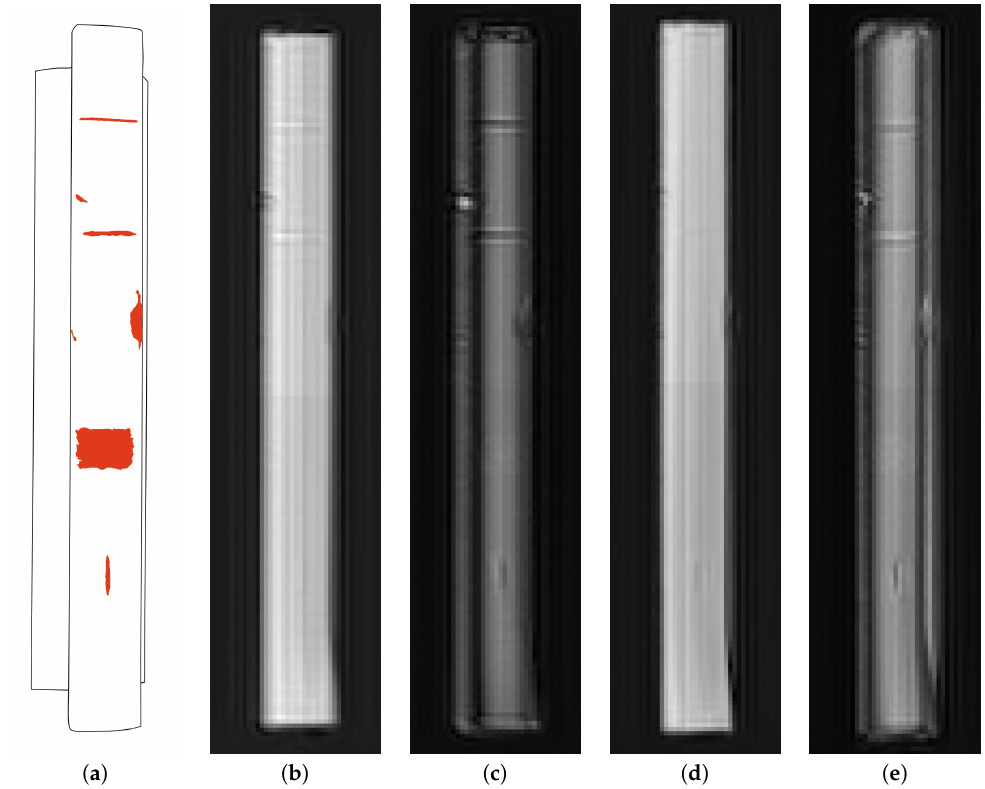
Figure 5. The map of defects and radar images of the rail fragment #1 in various transmit and receive polarizations: ( a ) the map of defects; ( b ) transmit and receive polarizations are along the rail fragment; ( c ) transmit polarization is along, receive polarization is across the rail fragment; ( d ) transmit and receive polarizations are across the rail fragment; ( e ) transmit polarization is across, receive polarization is along the rail